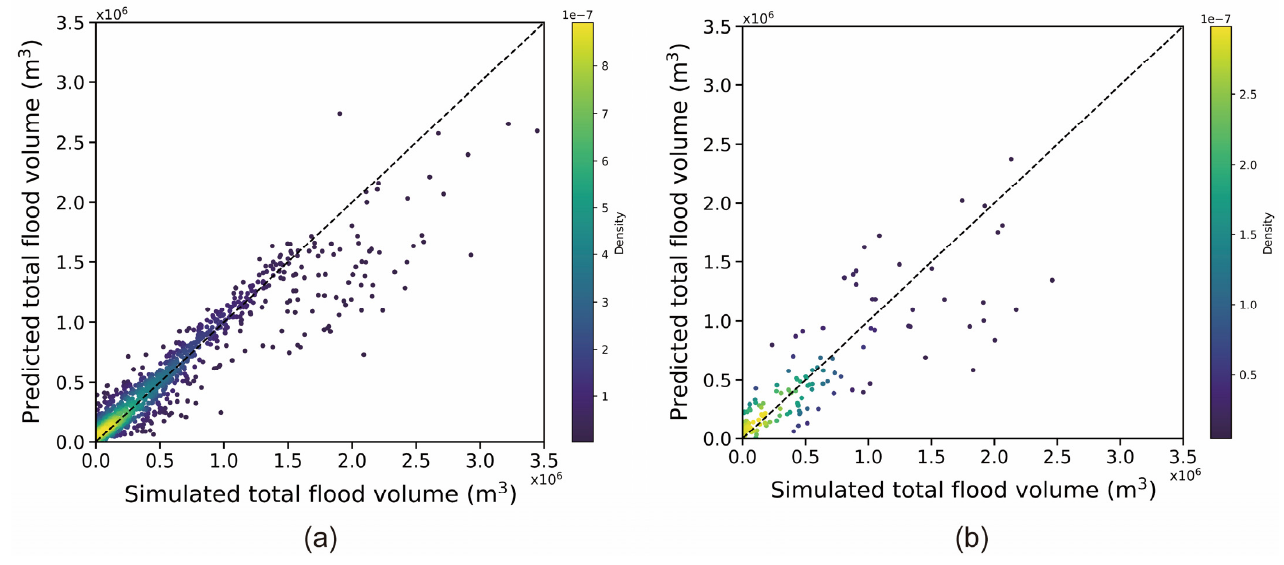
Figure 14. Total flooding volume predicted by AI versus the actual values: ( a ) training data and ( b ) testing data.